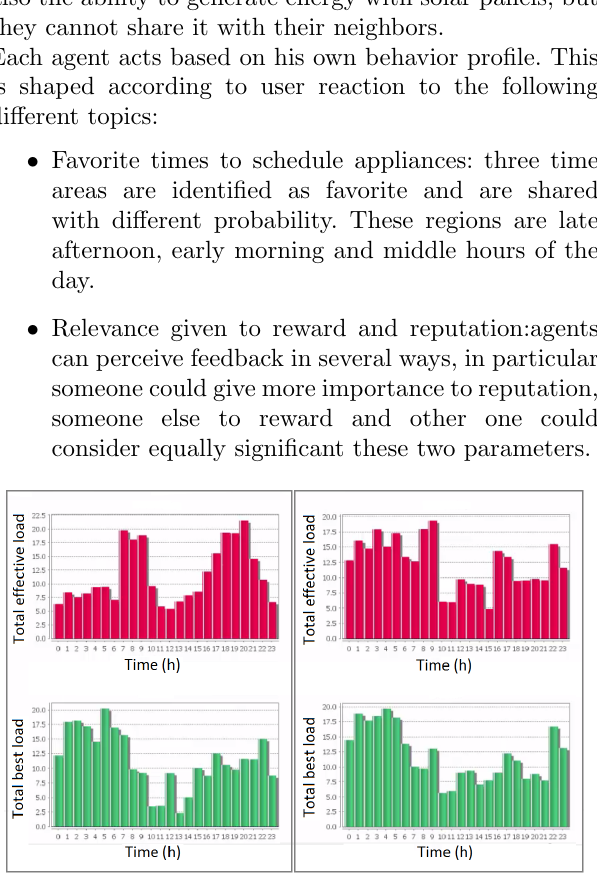
Figure 6. The charts are two examples of the values assumed by the total effective load (red) and the total best load (green) in the different hours of the day. The plot on the left represents the situation when the simulation starts, while in the right one the situation is